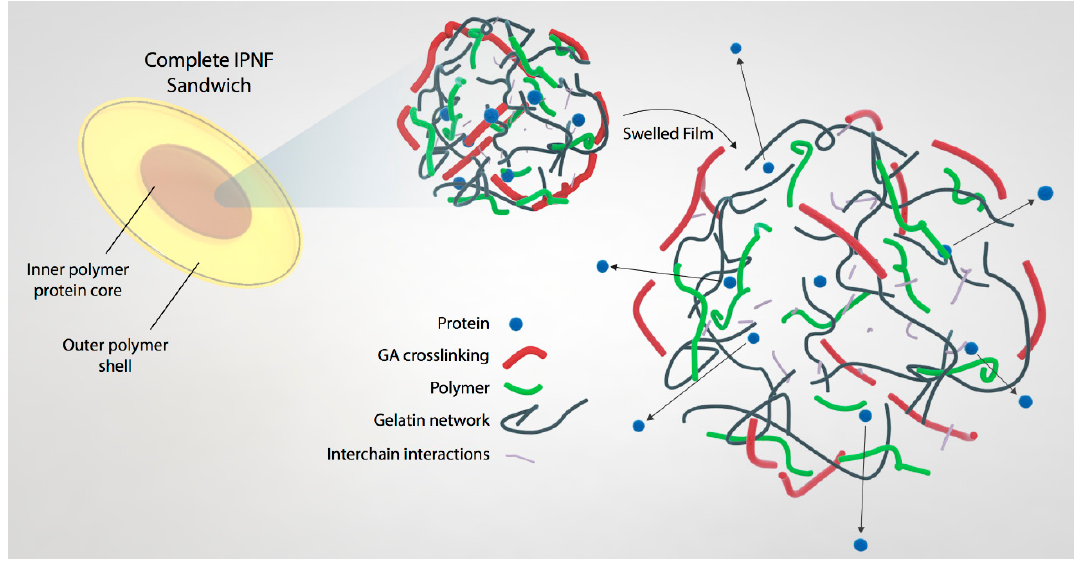
Figure 1. A structural model of the IPNFs pellet. The inner core consists of polymer-gelatin network and the load protein. This inner core is then encapsulated in an outer shell comprising of IPNF only.